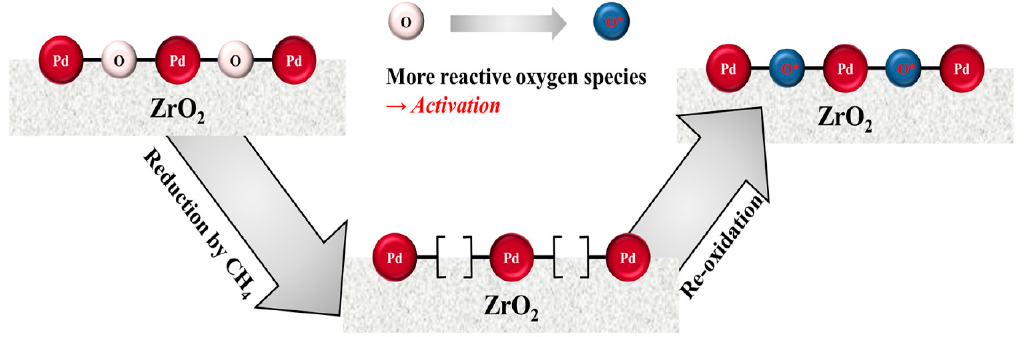
Figure 6. Schematic representation of activation phenomenon over the Pd / ZrO 2 catalysts through reduction / reoxidation during the methane combustion reaction.